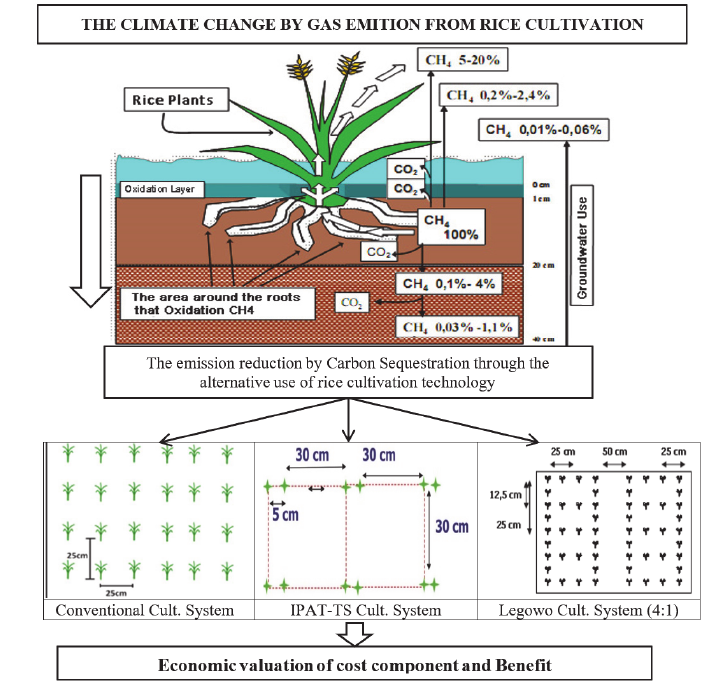
Fig. 1. Framework Analysis of Carbon Sequestration in Rice Paddy